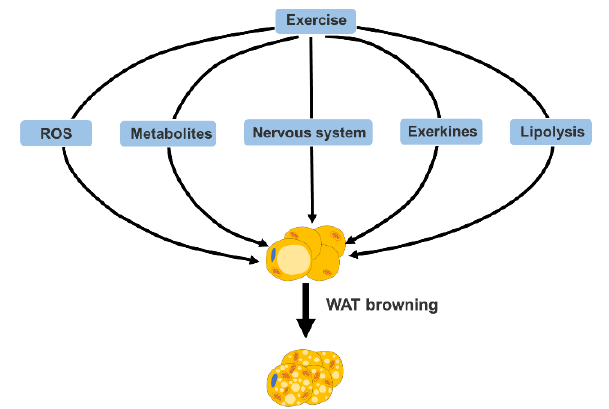
Figure 1. Mechanism of exercise-mediated WAT browning . Multiple factors, including reactive ox- ygen species (ROS), metabolites, nervous system, exerkines and lipolysis can facilitate exercise-mediated browning of WAT.